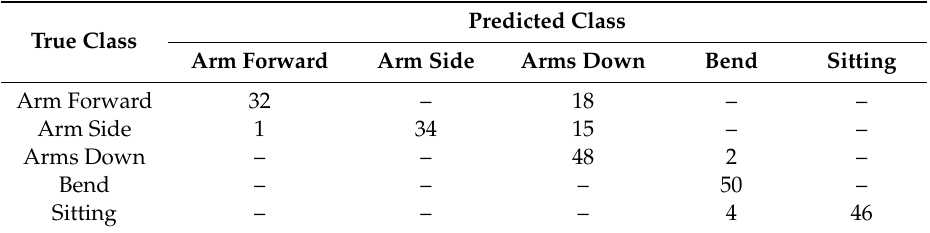
Table 13. Confusion matrix generated from implementing the Most Confident CNN approach to prediction selection for two corner TISs.